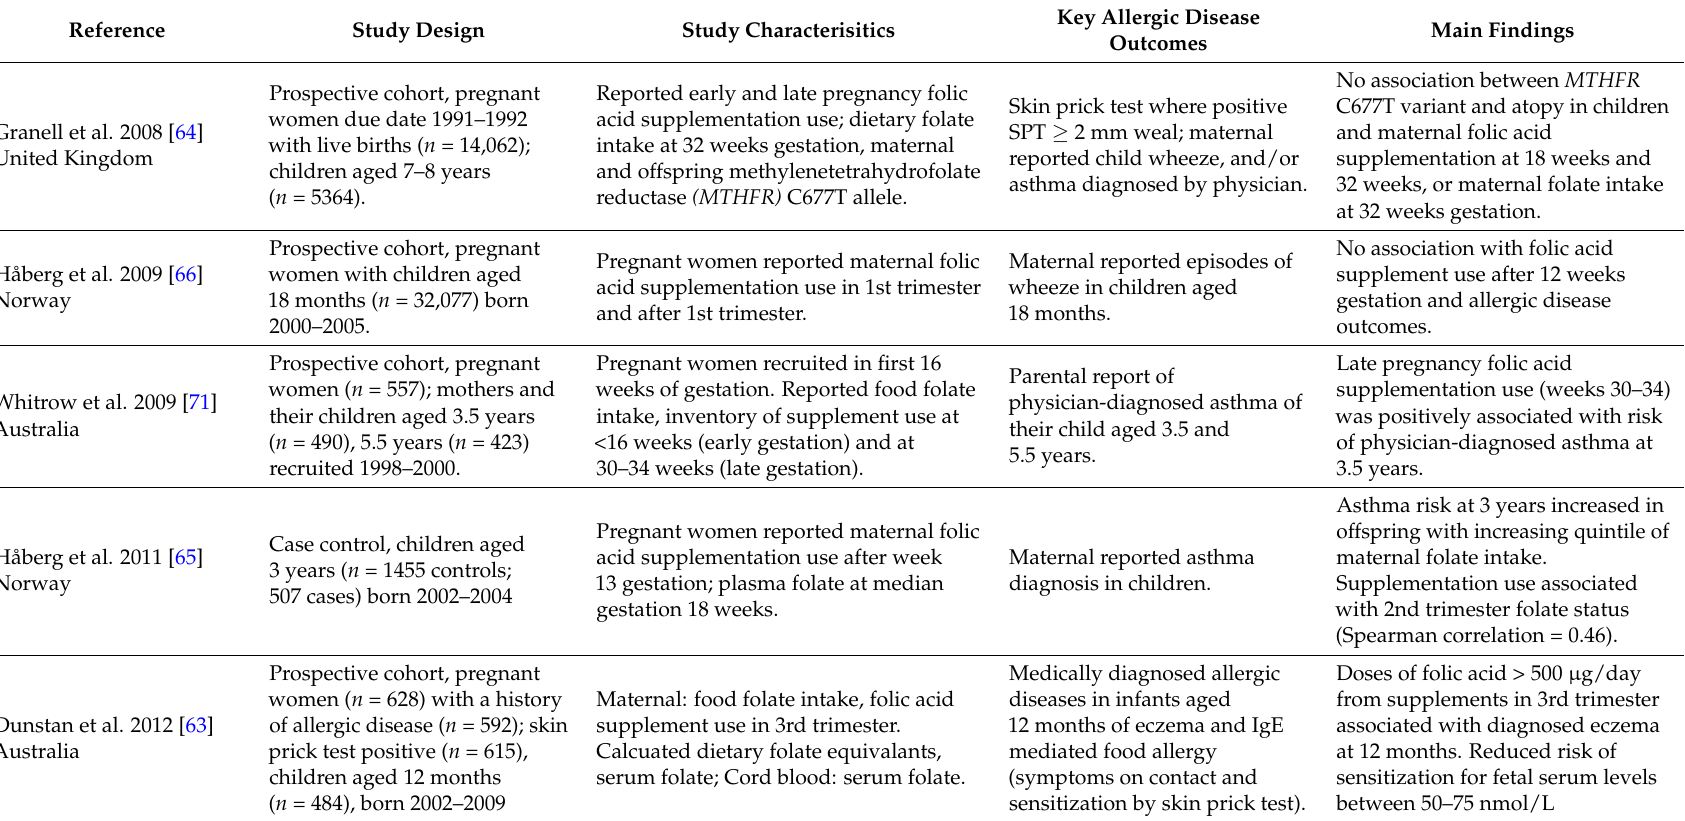
Table 1. Studies investigating the relationship between later pregnancy maternal folic acid supplementation and childhood allergic